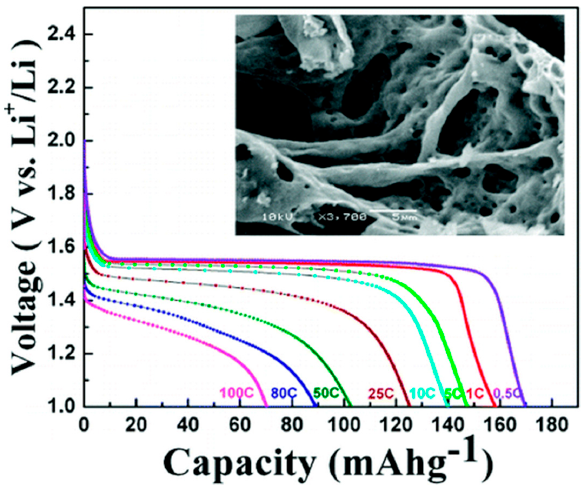
Figure 6. The capacity diagram of various lithium titanate (Reproduced with permission from Ref.